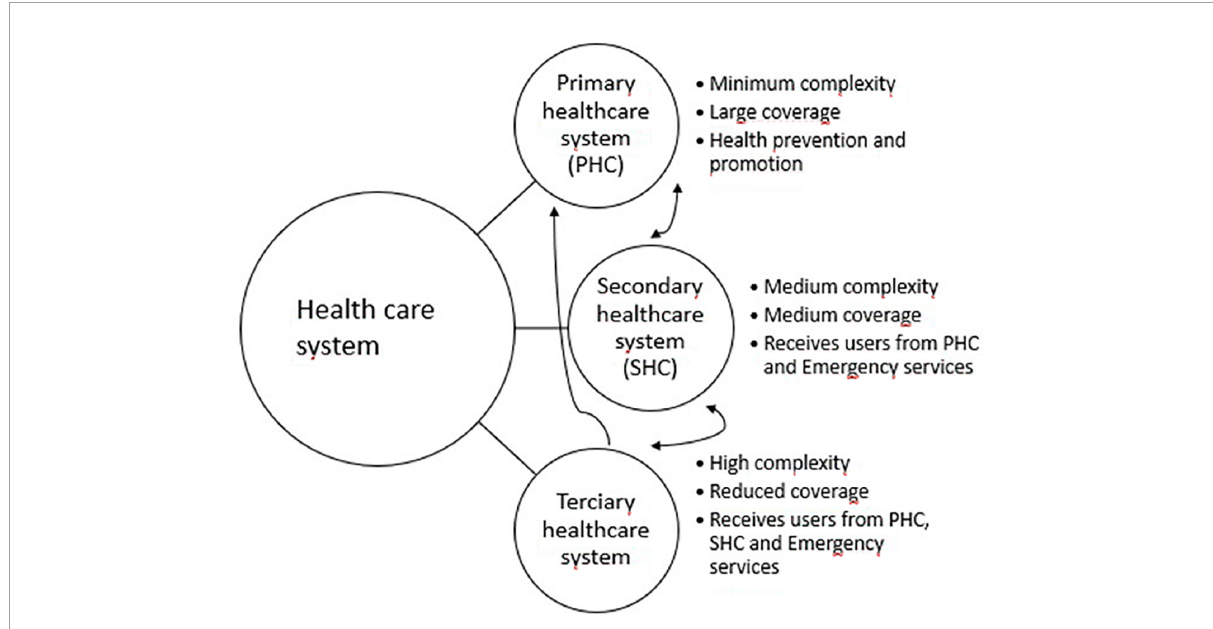
FIGURE2 Chile’s public health care